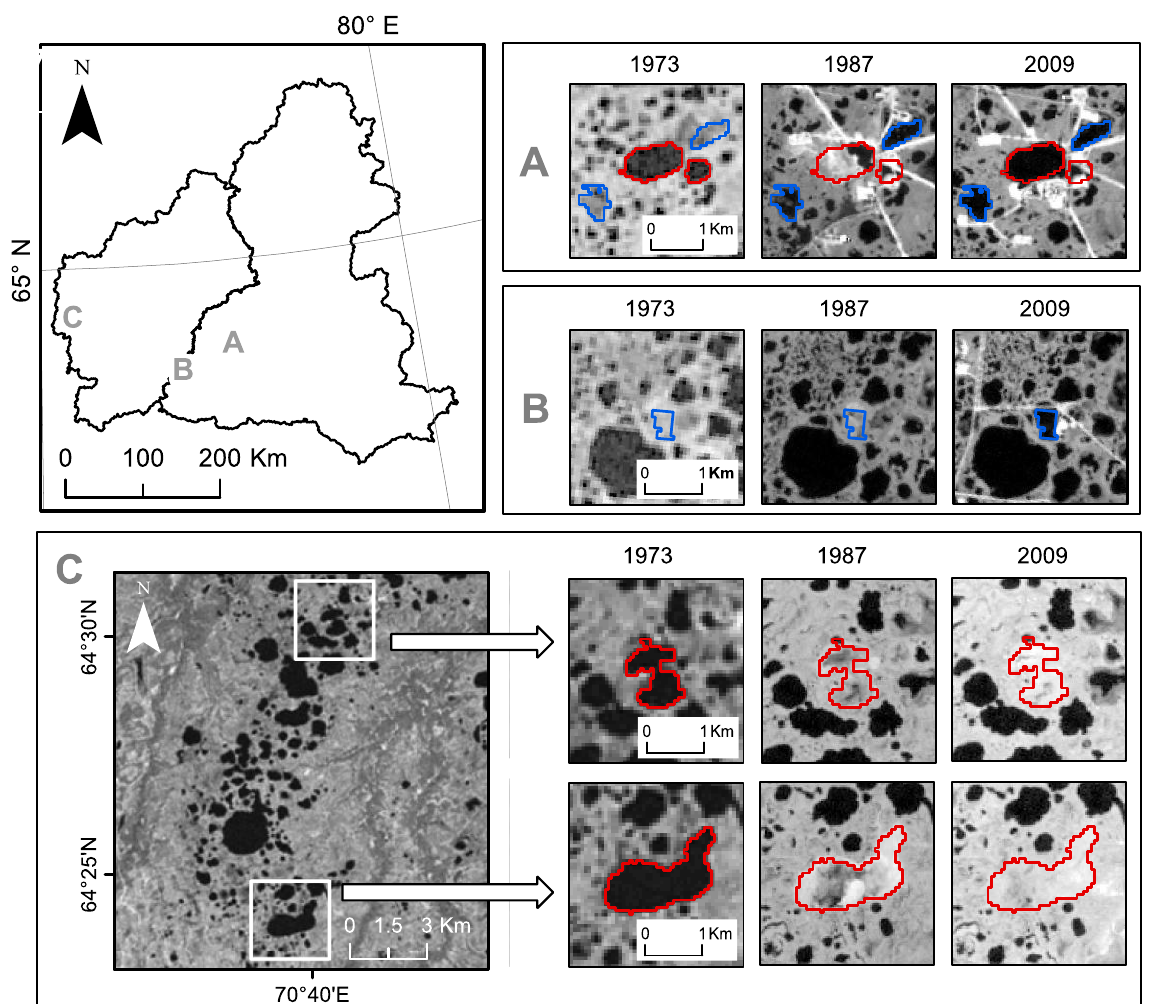
Figure 4. Examples of newly formed lakes (blue polygons representing the 2009 lake surface area) in the Pur river basin ( A , B ); and thermokarst lakes that have been drained (red polygons representing the 1973 lake surface area) in the Nadym river basin ( C ). White features in subset A and B are associated with infrastructure, e.g., road